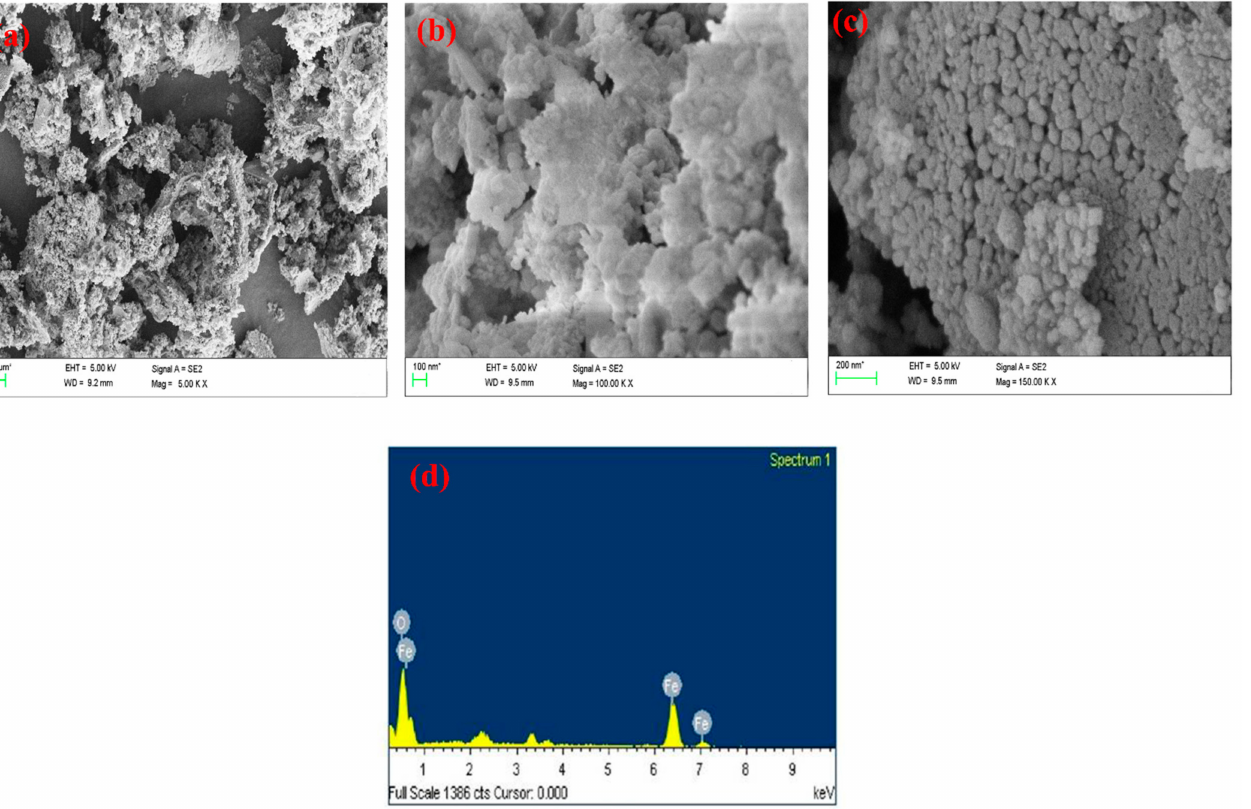
Figure 2. ( a – c ) FESEM image of prepared FNH nanoparticles at lower and higher magnifications and ( d ) EDAX spectrum of FNH